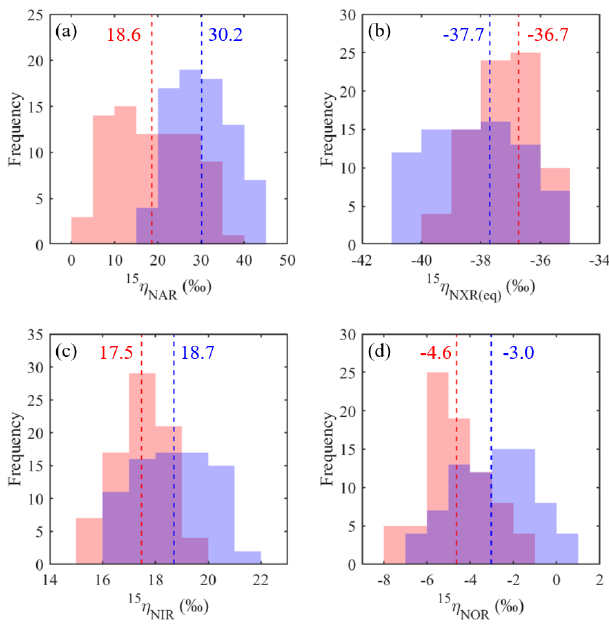
Figure 8. Frequency distributions of the best-fit 15 η NAR (a) , 15 η 15 η 15 η NIR (c) , and NXR(eq) (b) , NOR (d) under the no-exchange (red) and complete-exchange (blue) model scenarios. Dashed verti- cal lines denote the RSS-weighted mean 15 η values from the best-fit models under the two model